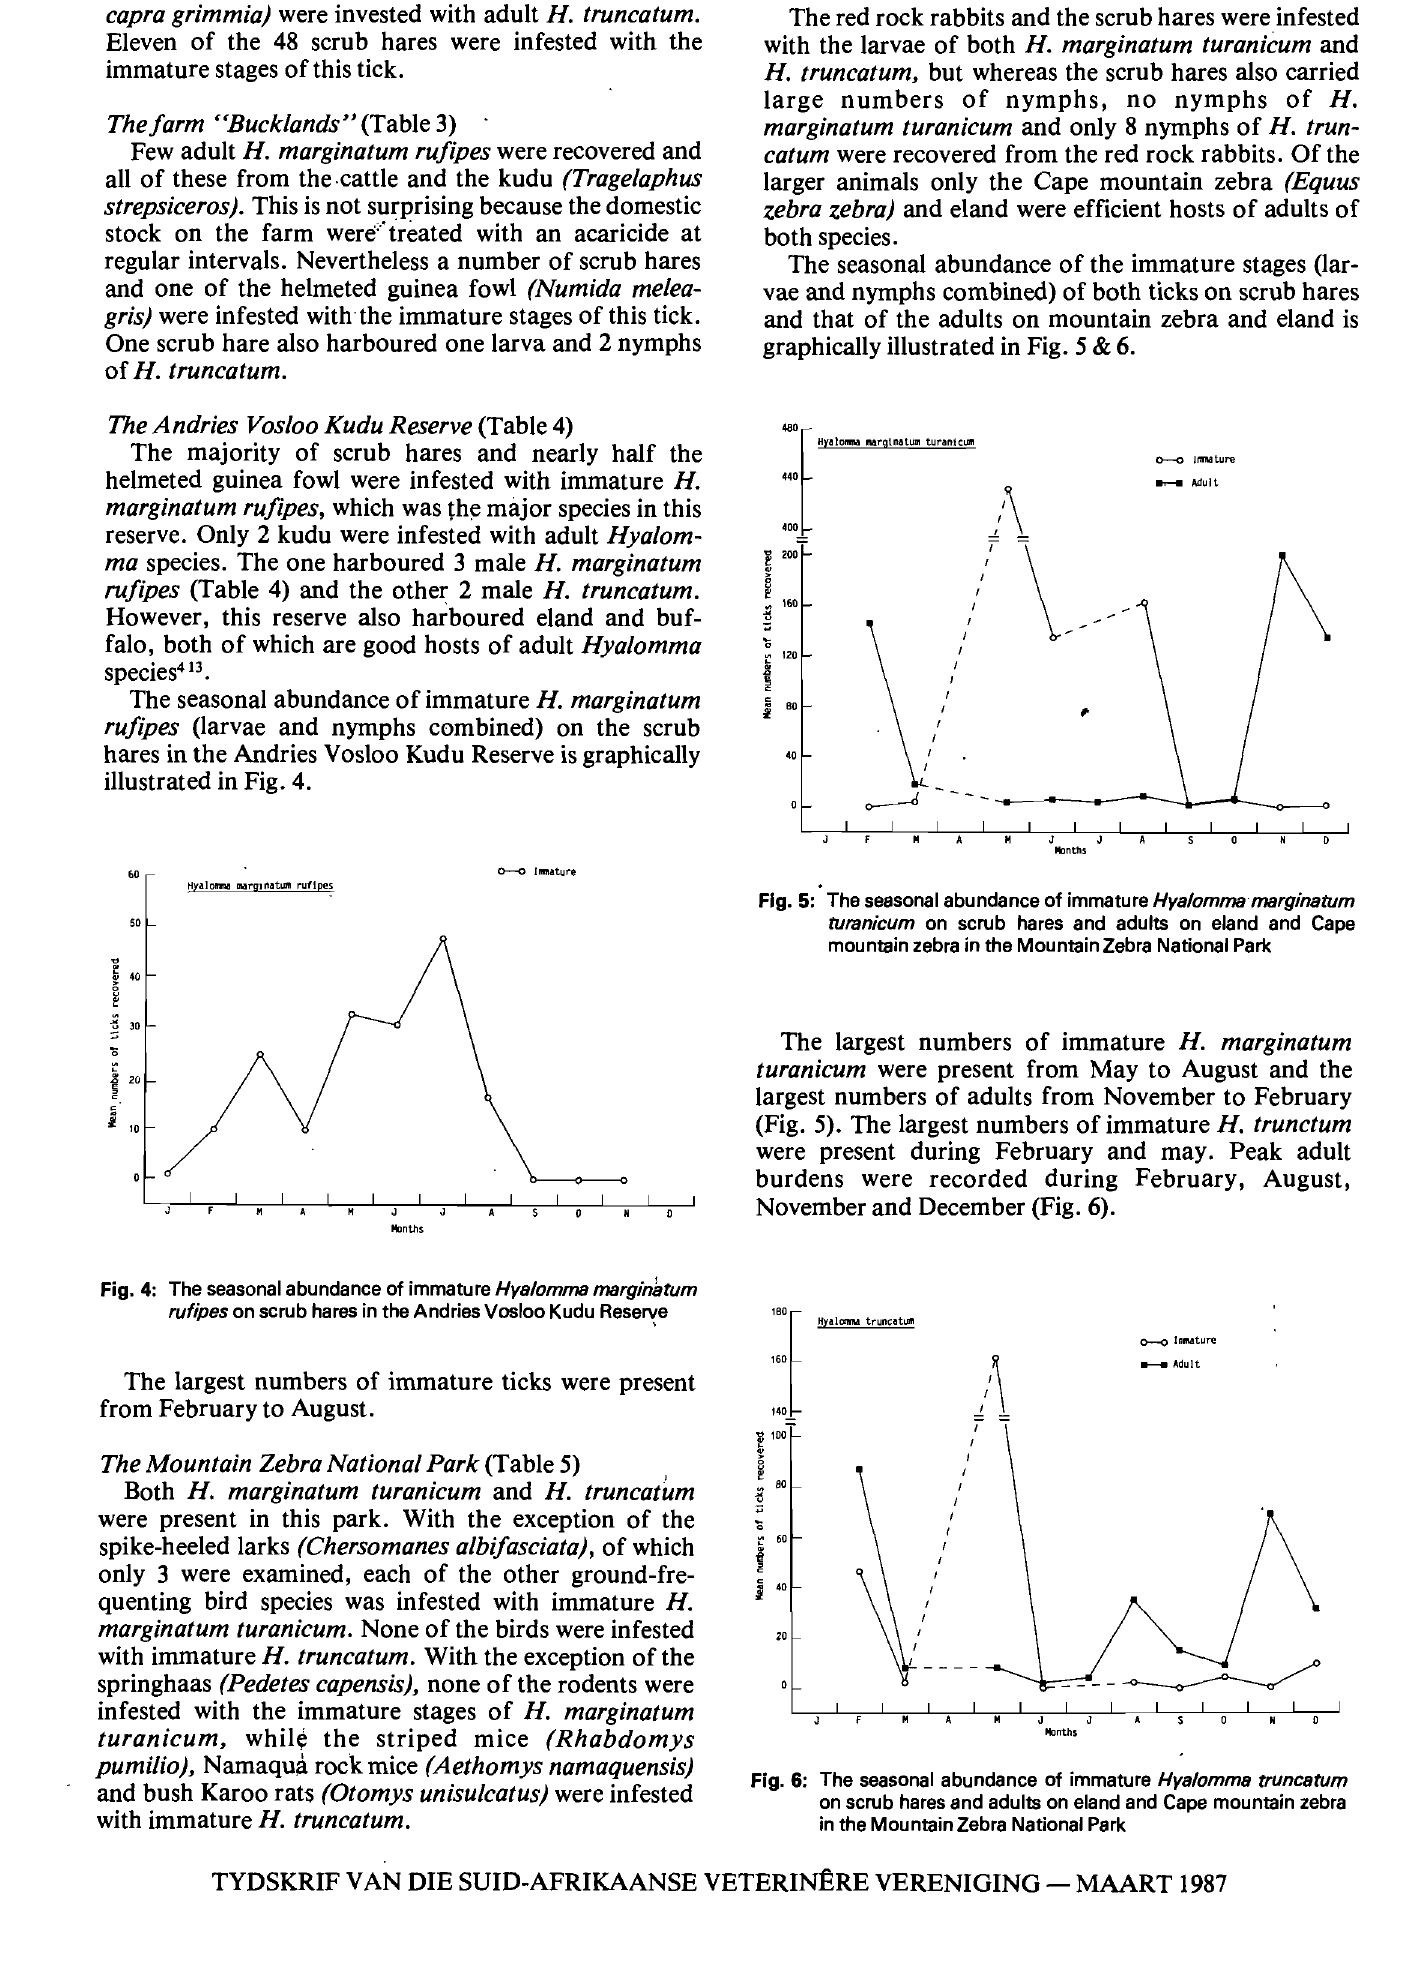
Fig. 6: The seasonal abundance of immature Hyalomma truncatum on scrub hares and adults on eland and Cape mountain zebra in the Mountain Zebra National Park TYDSKRIF VAN DIE SUID-AFRIKAANSE VETERINERE VERENIGING - MAART